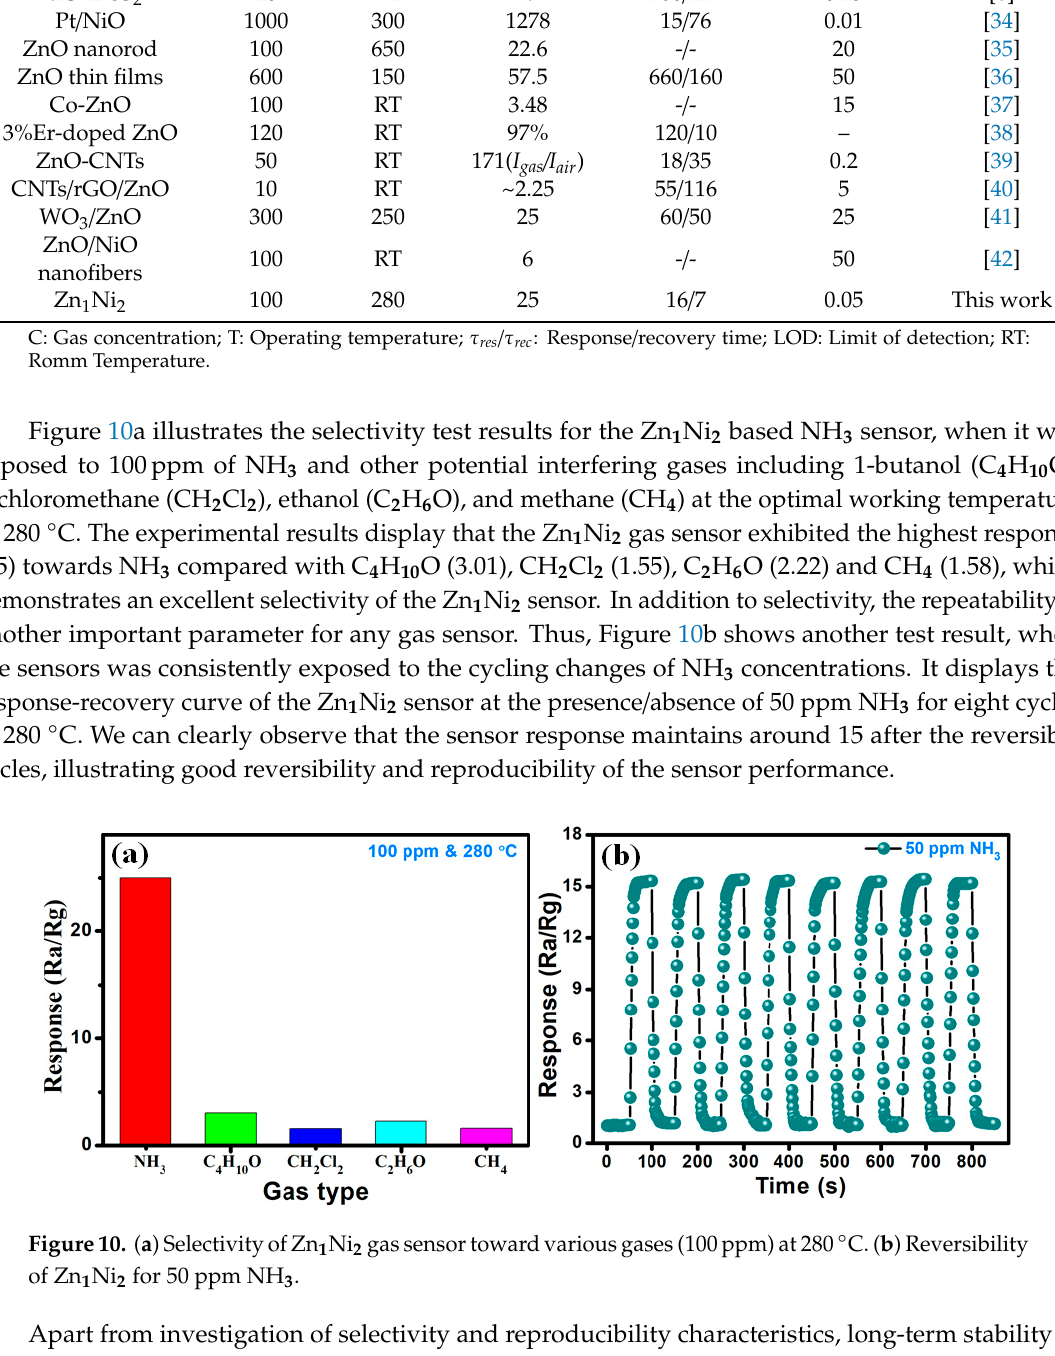
Figure 11. Long-term stability of as-prepared 3D n -ZnO/ p -NiO based sensors toward 50 ppm NH 3 at 280 °C . 3.3. Gas Sensing Mechanism For most of MOS-based gas sensors, the gas sensing mechanism can be explained by the resistance change on the surface of the sensing electrode material which is caused by adsorption and desorption of the target gas molecules [43]. The detailed sensing mechanism and the surface reaction